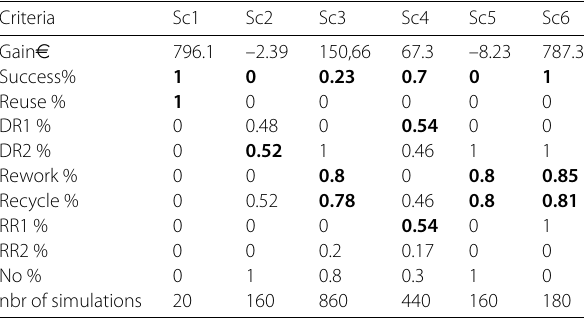
Table 6 Results of the six scenarios